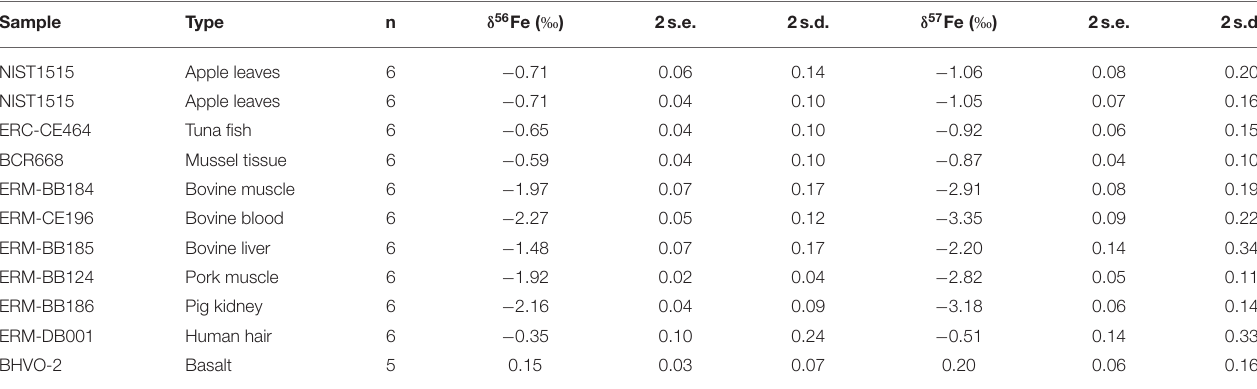
TABLE 2 | Iron isotopic compositions of nine biological